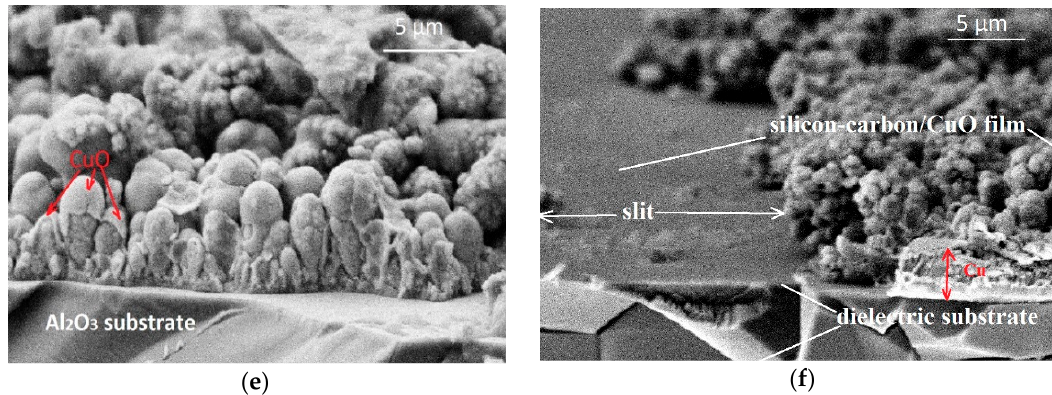
Figure 5. SEM micrographs of silicon-carbon films: ( a ) pure film on the type-1 chip; ( b ) film doped with CuO on the type-1 chip; ( c ) pure film on the type-2 chip; ( d ) film doped with CuO on the type-2 chip; and cross-sections of the ( e ) type-1 and ( f ) type-2 chips with the CuO alloy silicon-carbon film.